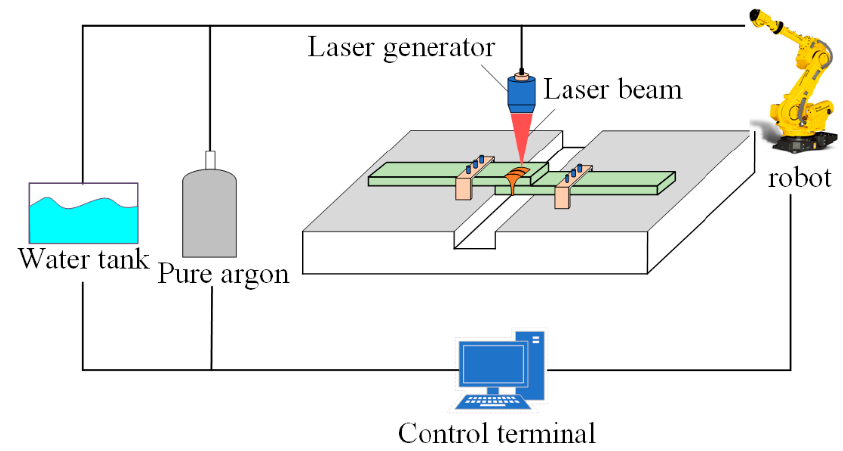
Figure 1. The schematic diagram of laser welding.